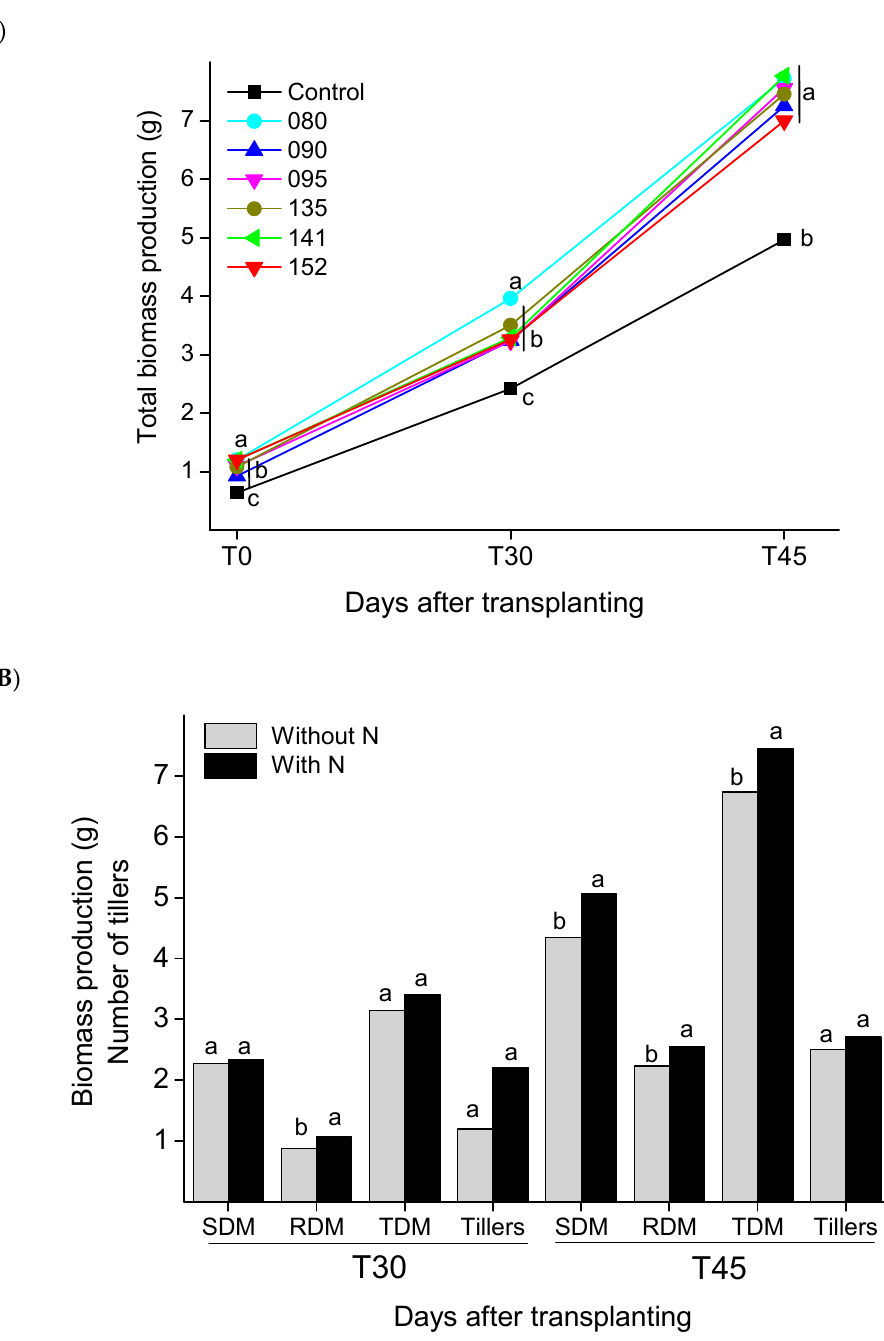
Figure 1. ( A ) Total biomass produced by sugarcane seedlings inoculated or not (Control) with six different bacterial strains (080, 090, 095, 135, 141, and 152) at day of transplanting (T0), 30 (T30) and 45 (T45). ( B ) Shoot dry matter (SDM), root dry matter (RDM), total dry matter (TDM), and number of tillers (Tillers) of sugarcane seedlings with (black bars) and without (gray bars) nitrogen fertilizer, 30 (T30) and 45 (T45) days after transplanting. Different letters (a–c) indicate significant differences among inoculation treatments within each analyzed time by the Scott-Knott test ( p < 0.05).